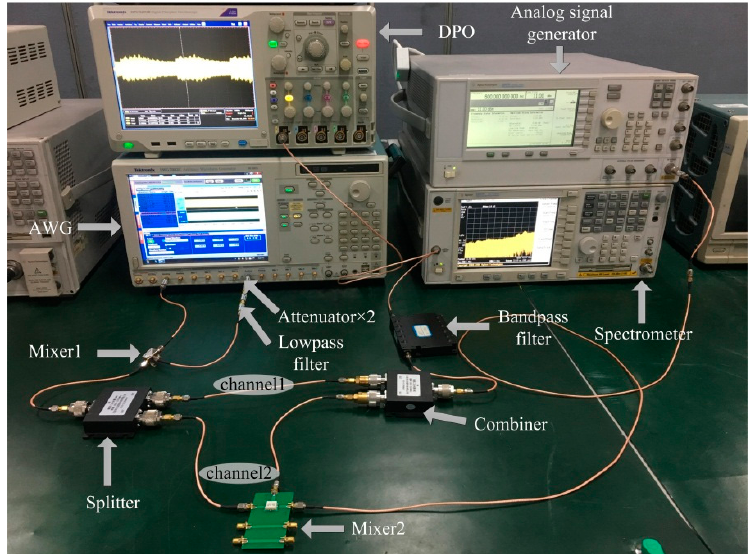
Figure 11. Experiment circuit for the FCS M-C arrangement.